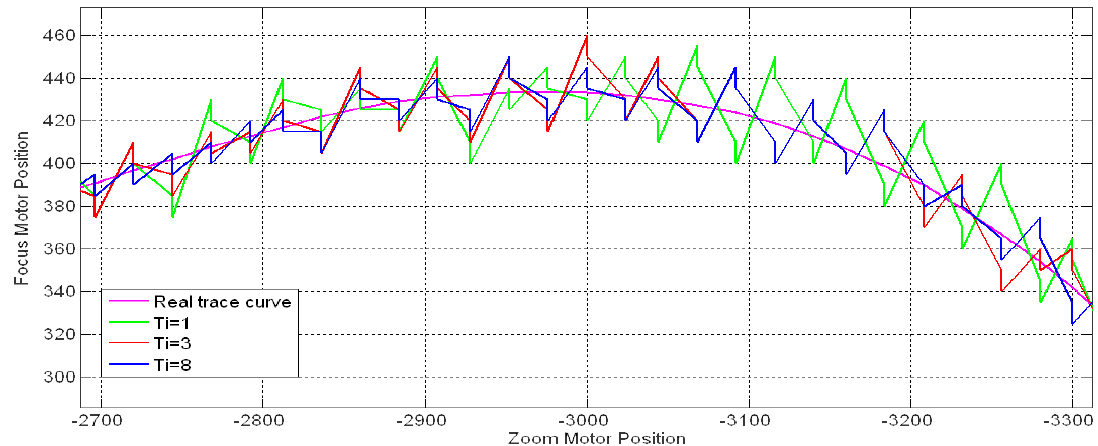
Figure 21. Feedback response curves for different integral